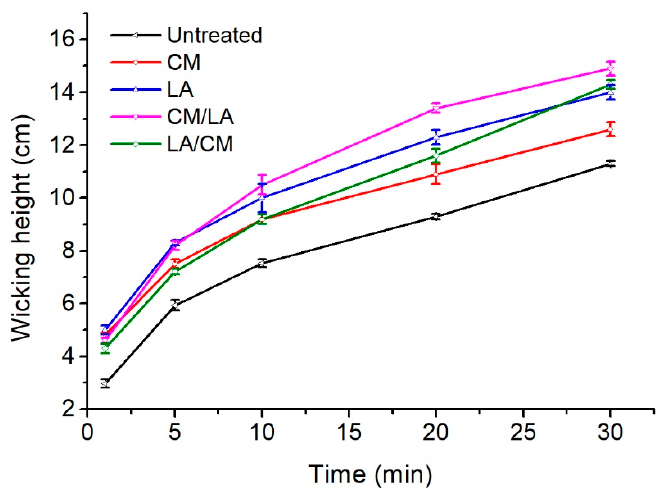
Figure 6. Wicking heights of the untreated and treated cotton fabrics at different test times.